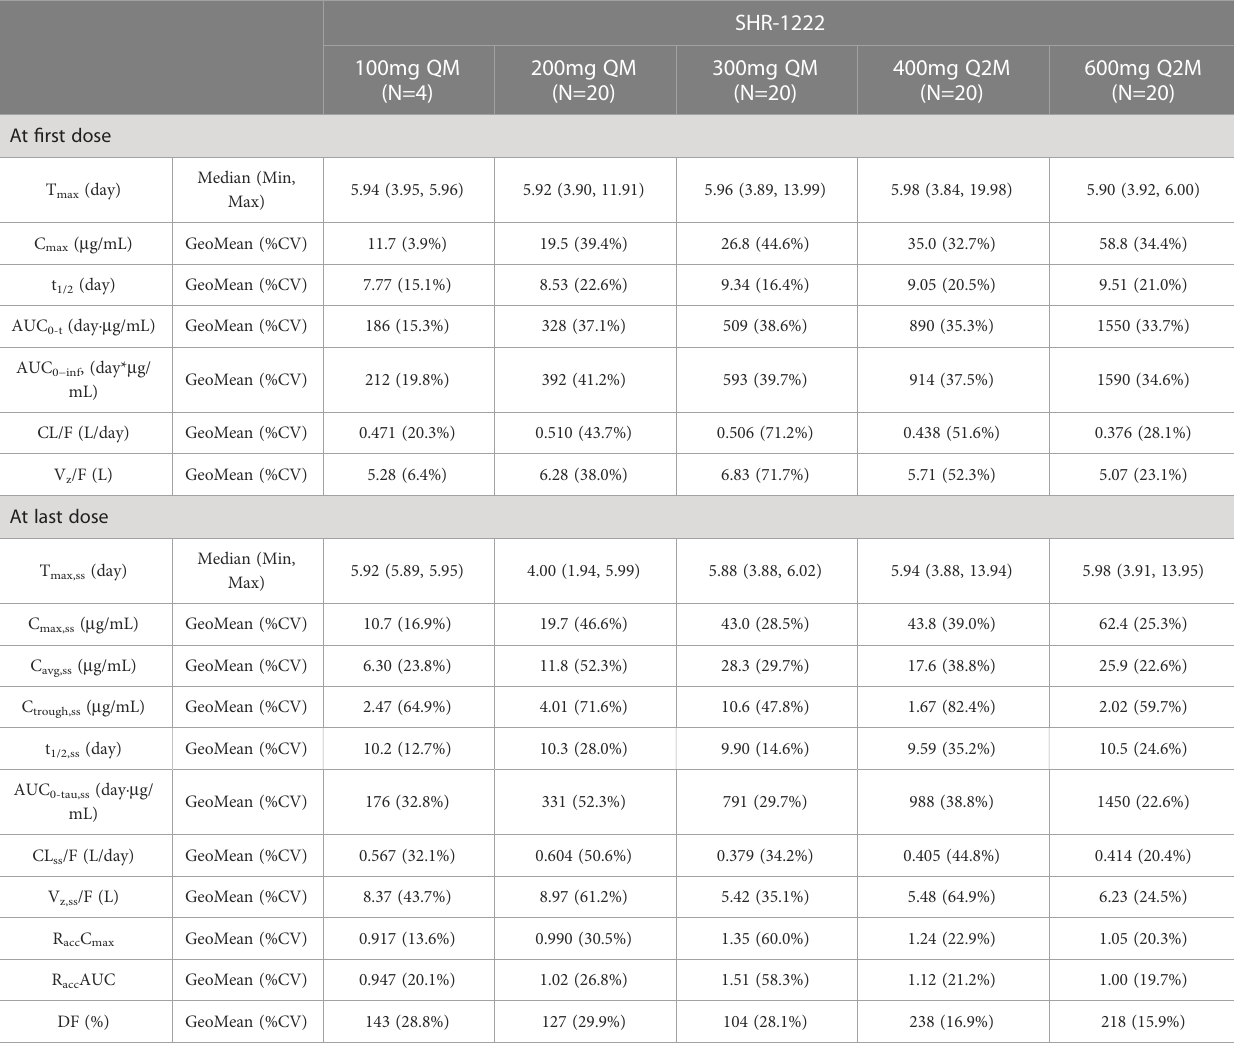
TABLE 3 Pharmacokinetics of SHR-1222: noncompartmental parameter estimates.